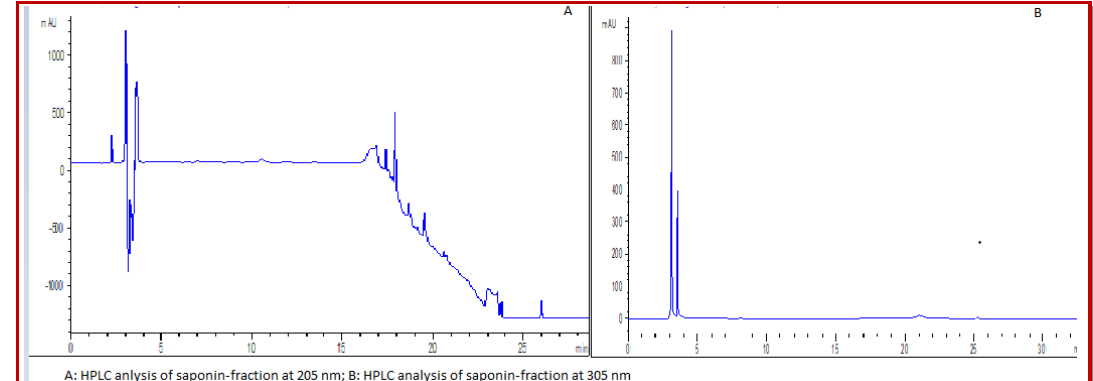
Figure 1: Analysis of bioactive compound by